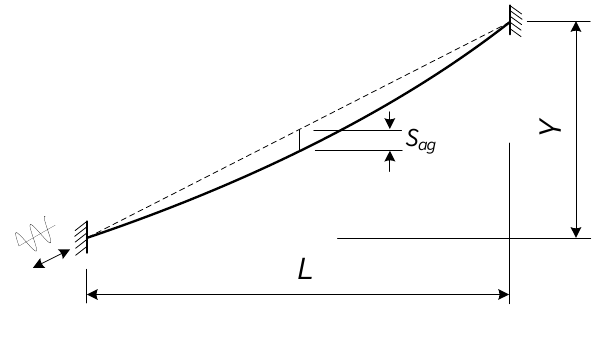
Figure 11. Parametric vibration analysis model of the stay cable.